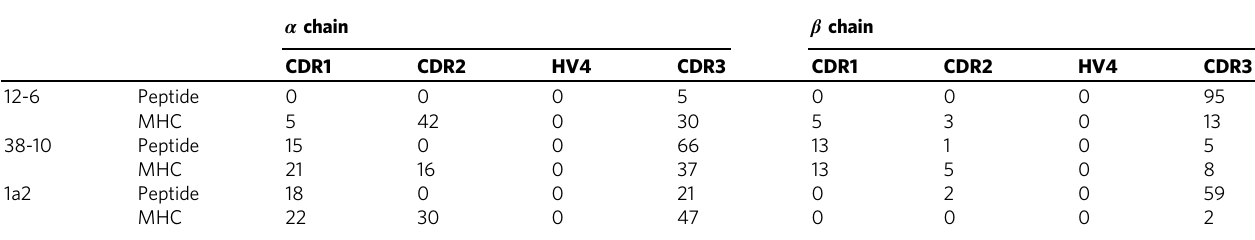
Contacts were calculated between non-hydrogen atoms with a 4.0Å distance cutoff.